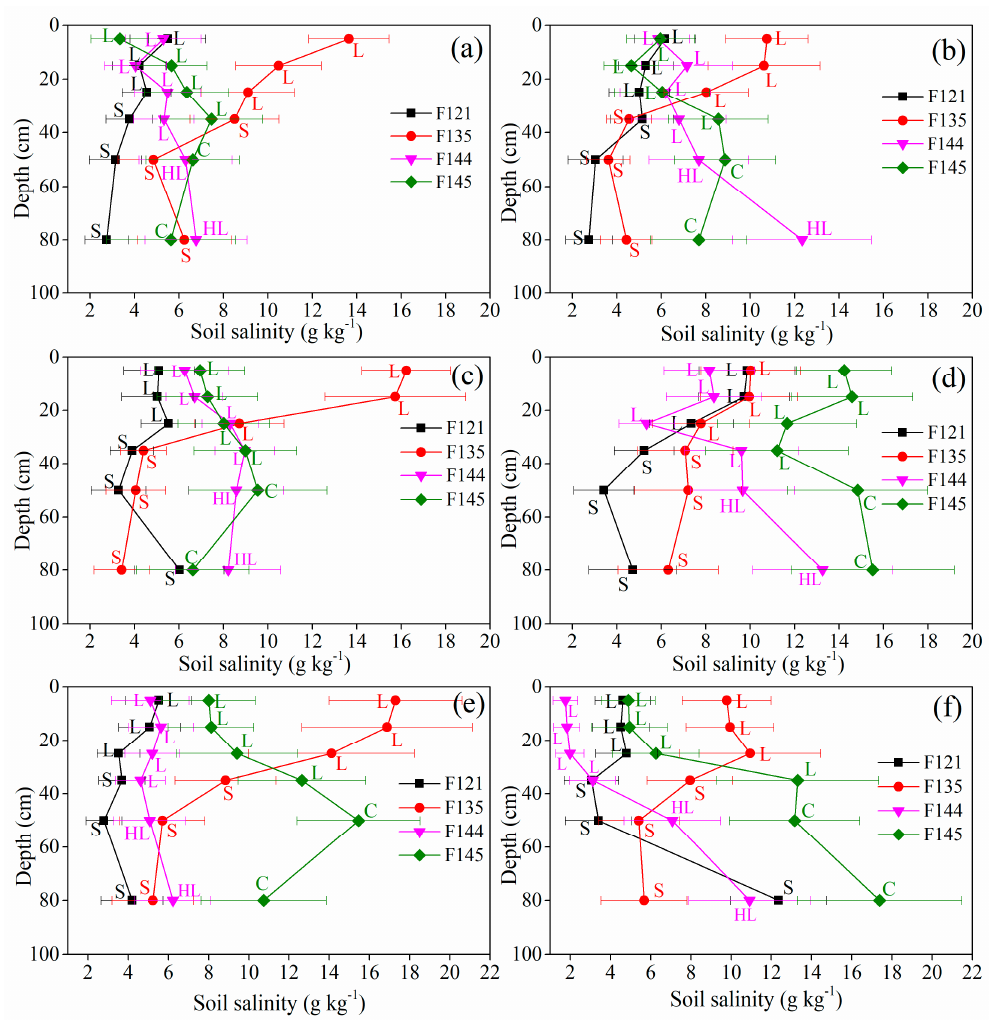
Figure 5. Distribution of soil salinity and soil texture at di ff erent soil depths in salt wastelands under mulched drip irrigation, 2011–2016 (( a )–( f ): 2011–2016, S: sand, L: loam, HL: heavy loam, C: